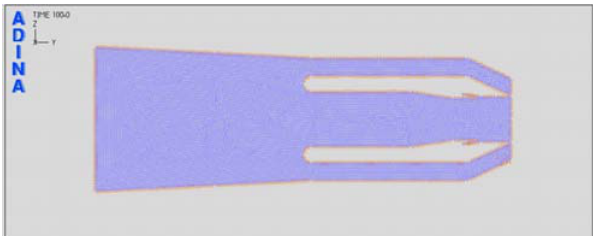
Fig 5. The sample of generated final element mesh on ADINA system